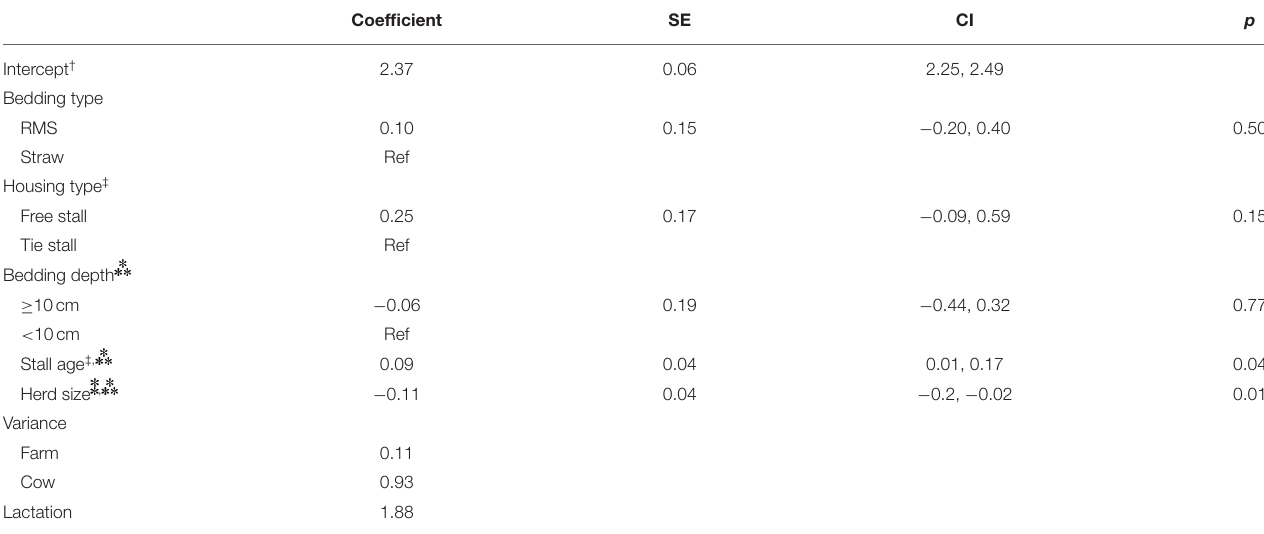
TABLE 2 | Impact of bedding on the cow’s mean lactation linear score estimated using a generalized linear mixed model using the data from 15,161 lactations of 11,031 cows from 20 recycled manure solids (RMS) farms and 60 straw-bedded farms.